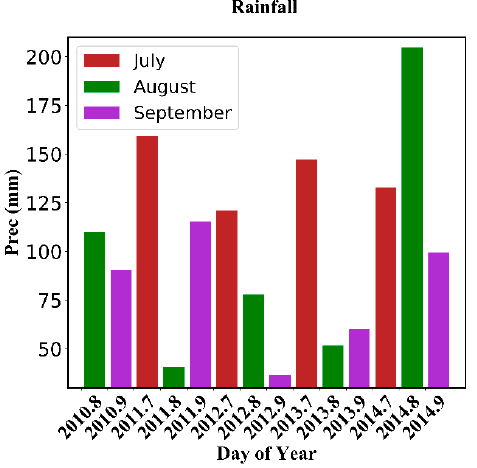
Figure 5. Rainfall in July, August, and September from 2010–2014.